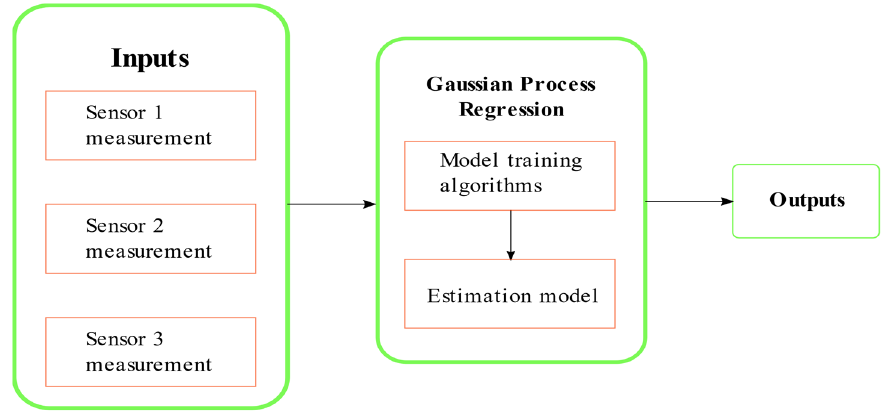
Figure 6. Application of Gaussian process regression in data-quality improvement.